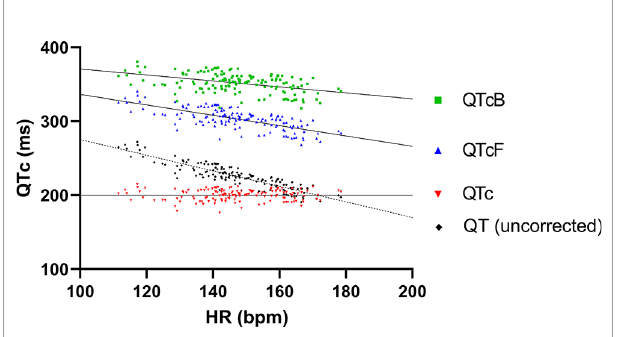
FIGURE 3 | QT and different QT correction formulas applied on baseline recordings plotted as functions of heart rate. Linear regression of both Bazett's and Fridericia's formulas (QTcB and QTcF, respectively) revealed slopes that signi fi cantly deviated from zero ( − 0.41 ± 0.07 and − 0.70 ± 0.06, respectively). In comparison the slope of linear regression of the study-speci fi c formula was <0.0001 ± 0.04 which was not signi fi cantly different from zero.